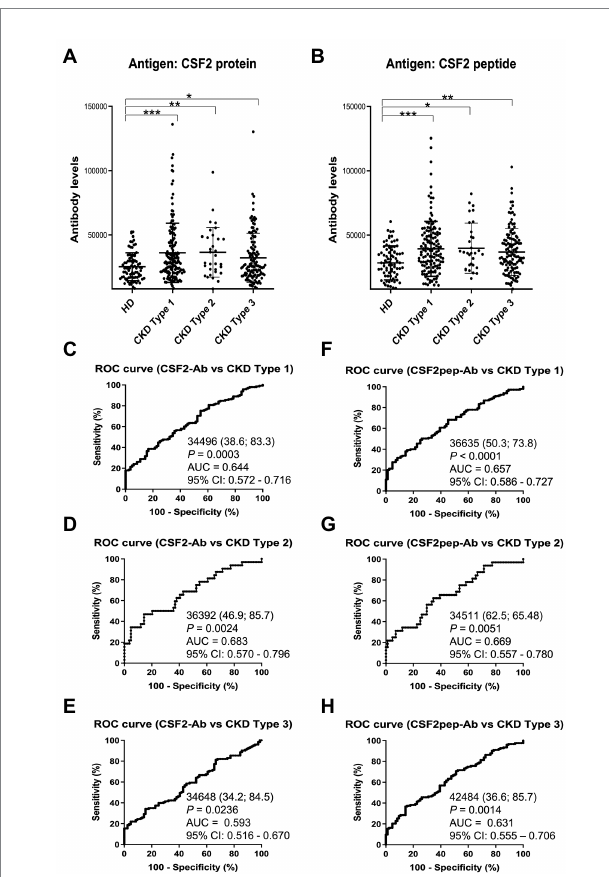
FIGURE 4 Association of the s-CSF2-Ab and s-CSF2pep-Ab levels with CKD. The levels of s-CSF-Ab ( A ) and s-CSF2pep-Ab ( B ) in HDs and in patients with diabetic CKD (CKD type 1), nephrosclerosis (CKD type 2), and glomerulonephritis (CKD type 3) were examined using AlphaLISA. The bars represent averages ± SD. * P < 0.05; ** P < 0.01; *** P < 0.001, Kruskal– Wallis test. The data are summarized in Table 3. ( C–E ) ROC analysis to determine the ability of s-CSF2-Ab to predict CKD type 1 ( C ), type 2 ( D ), and type 3 ( E ). ( F–H ) ROC analysis to determine the ability of s-CSF2pep-Ab to predict CKD type 1 ( F ), type 2 ( G ), and type 3 ( H ). The numbers in the graphs are the same as those presented Figure 2. CKD, chronic kidney